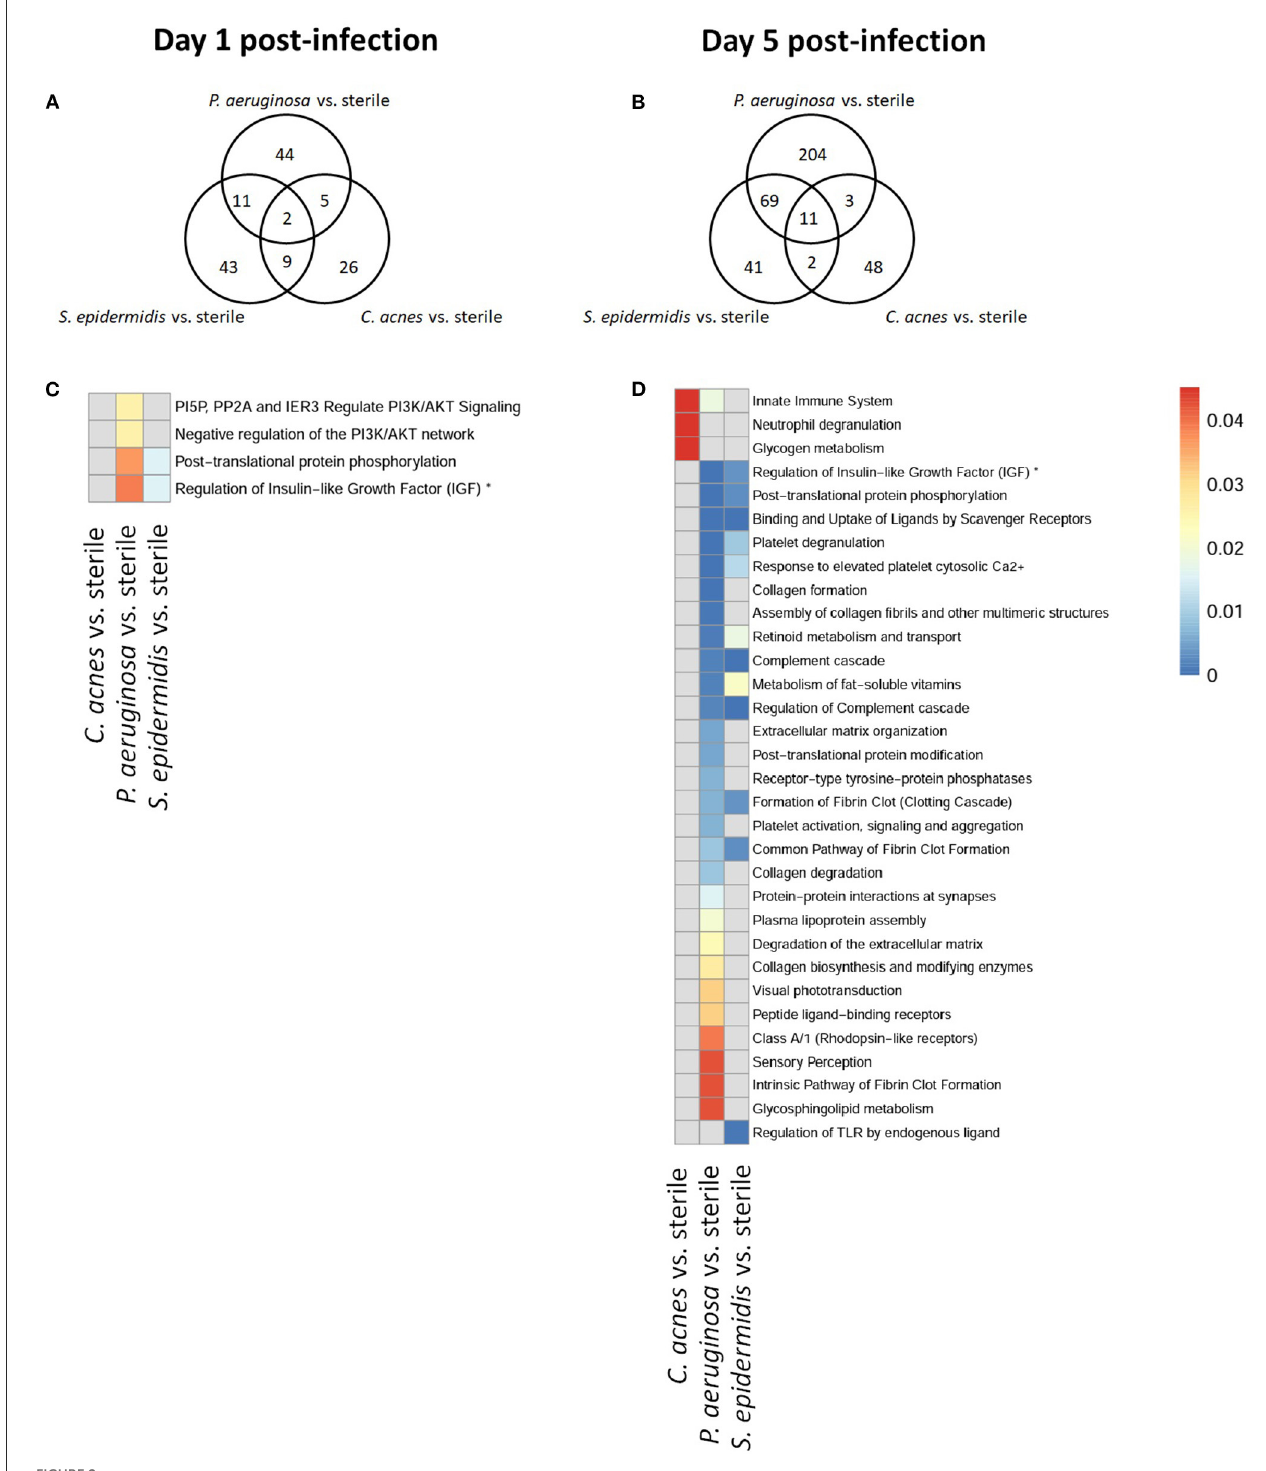
FIGURE2 Quantity of differentially expressed proteins in P. aeruginosa , C. acnes , and S. epidermidis infection and overlap between infection types at early time points, day 1 (A) and 5 (B) post-infection as well as functional enrichment at day 1 (C) and 5 (D) post-infection. *Represents abbreviation of regulation of Insulin-like Growth Factor (IGF) transport and uptake by Insulin-like Growth Factor Binding Proteins